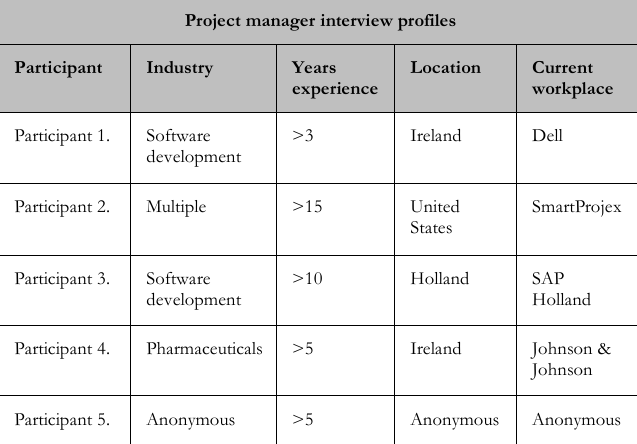
Table 2. Analysis of participant